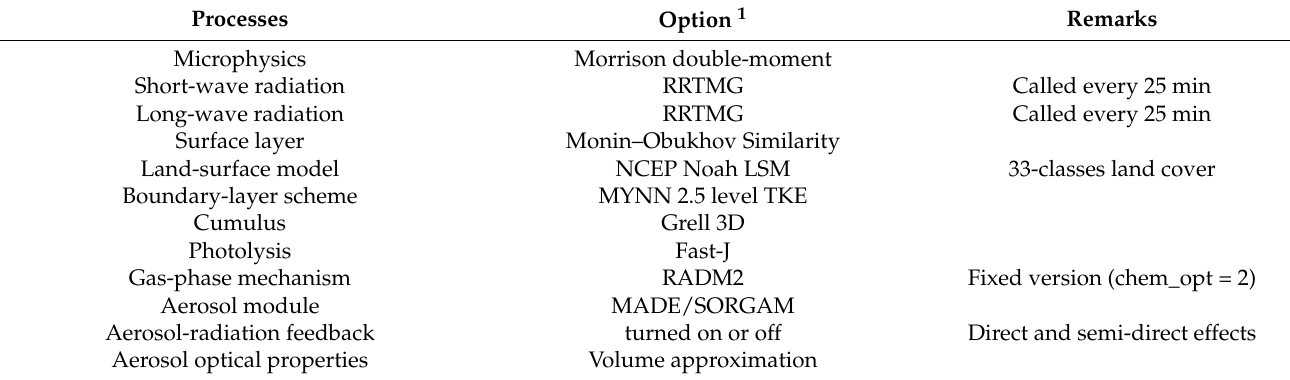
Table 1. Main physical and chemical parametrizations used in the WRF-Chem simulations.